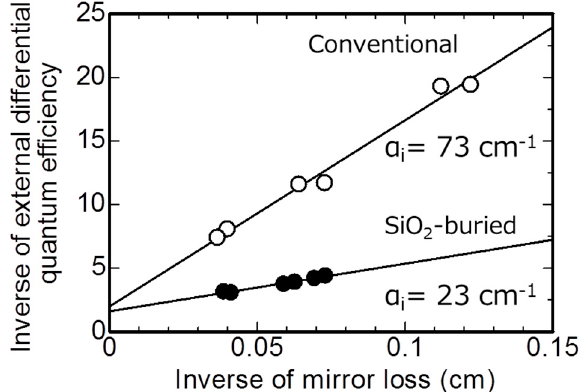
Figure 4. Inverse of external differential quantum efficiency as a function of the inverse of the mirror loss. The open and closed circles indicate the results obtained from VCSELs having a conventional SiO 2 aperture and a SiO 2 -buried lateral optical confinement structure, respectively.